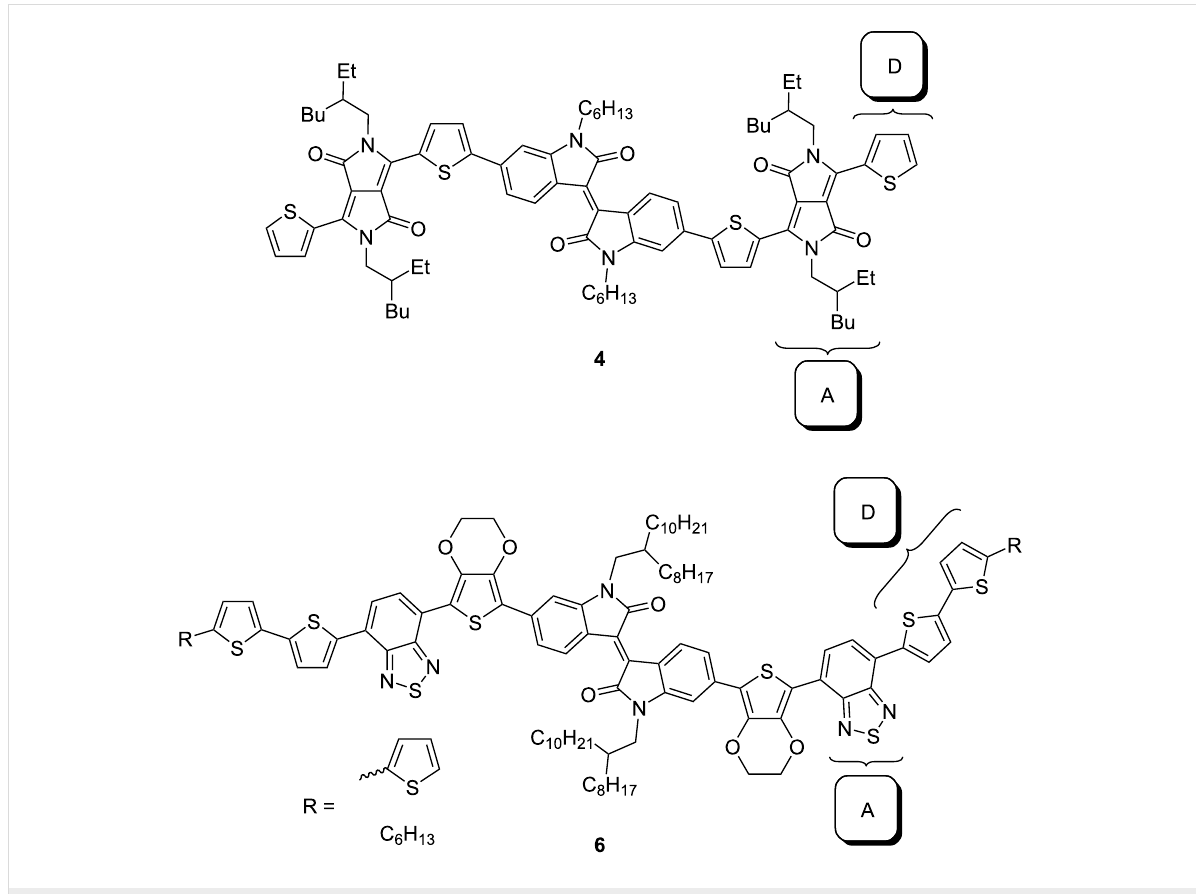
Scheme 5: Isoindigo structures with incorporated acceptor nitrogen